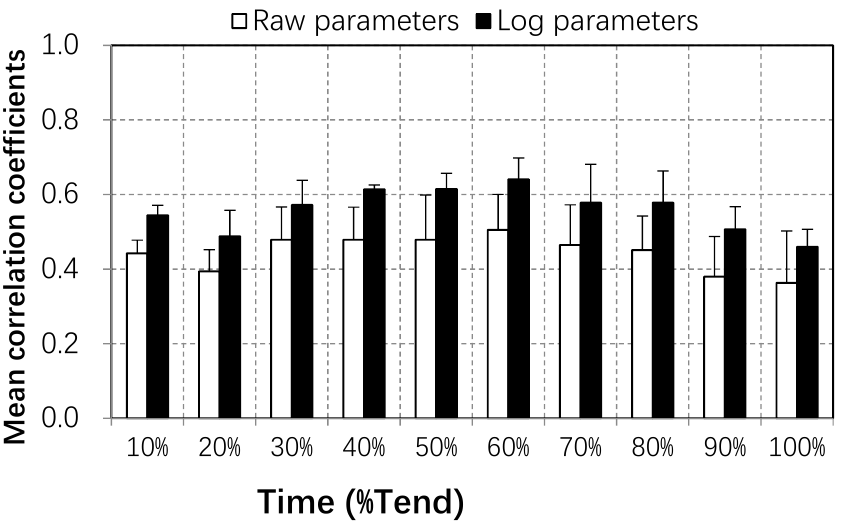
Figure 13. Comparison of mean and standard deviation of the correlation coefficients of raw and logarithmic parameters as described in Table 6 (a) and (b).